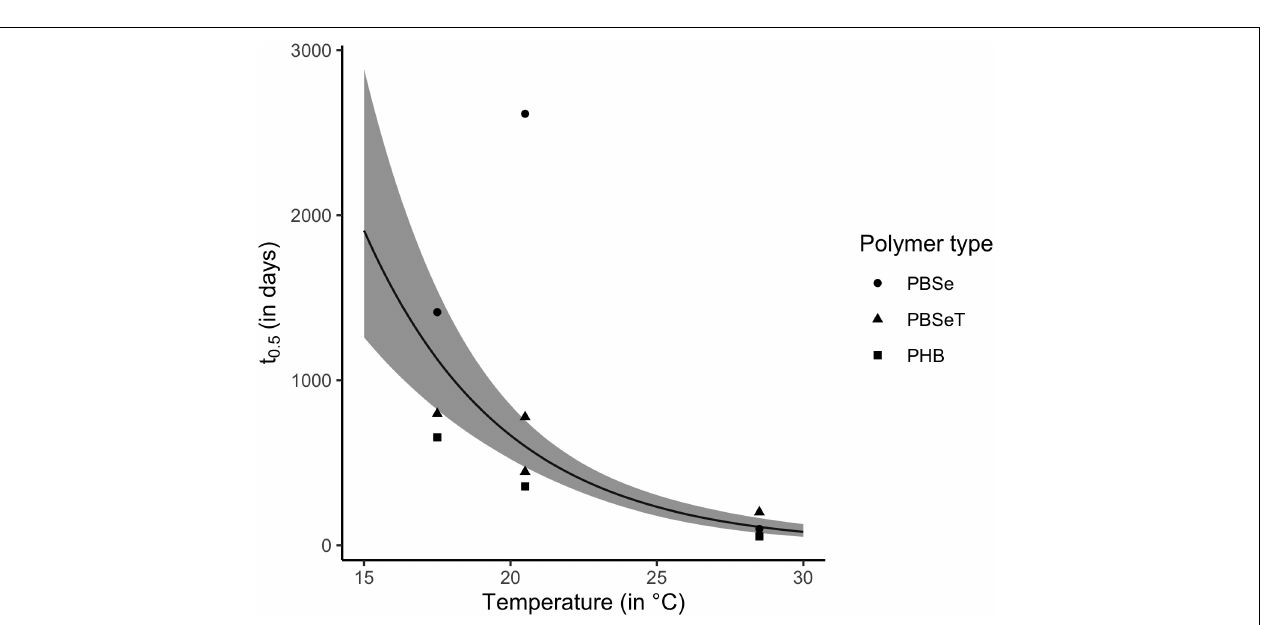
FIGURE 8 | Field experiments in tropical SE-Asia: Disintegration curves of (A) PHB, (B) PBSeT, and (C) PBSe exposed on the seafloor sediment-seawater interface (benthic) for almost one year (310 d). The model curve ± 95% CI (shaded area) was drawn if the slope was different from zero and positive. Squares represent raw data analyzed.